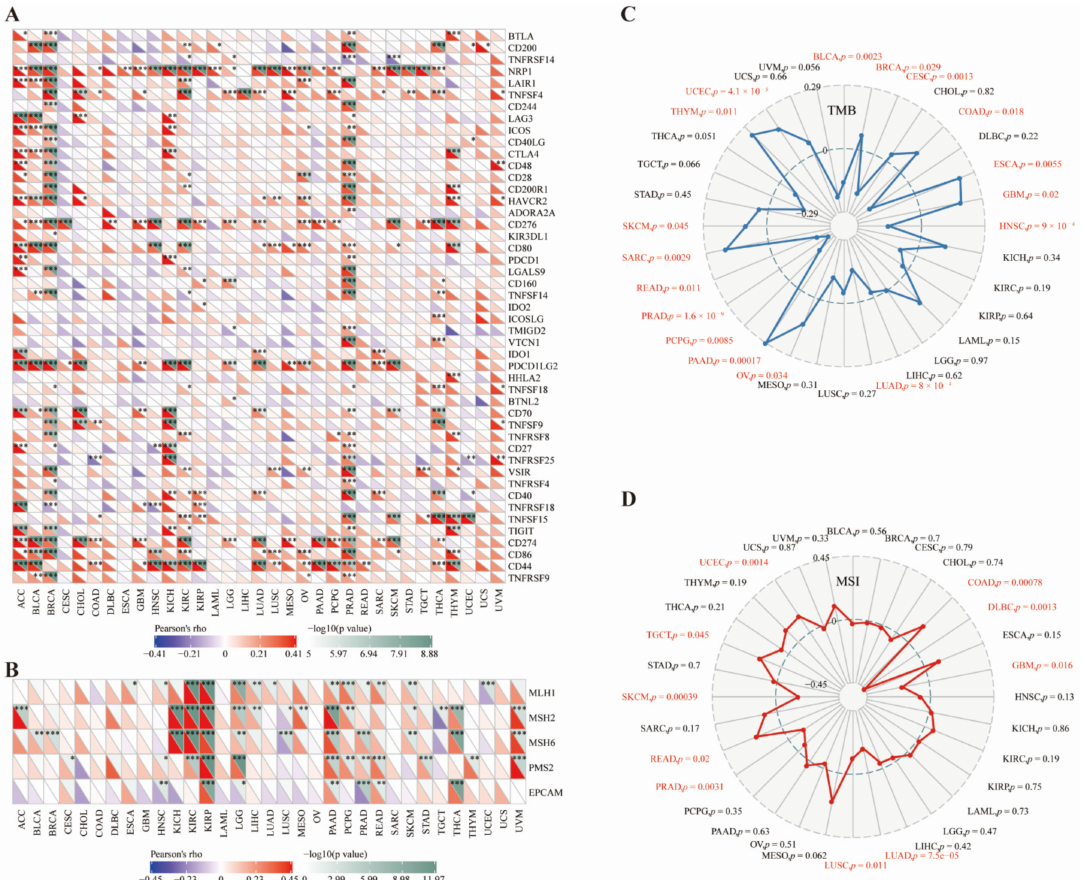
Figure 3. CD73 shows close correlation with immune checkpoints, DNA MMR markers, TMB, and MSI. Relationship between CD73 levels and classical immune checkpoints ( A ), DNA MMR markers ( B ), TMB ( C ), and MSI ( D ). * p < 0.05, ** p < 0.01, *** p <